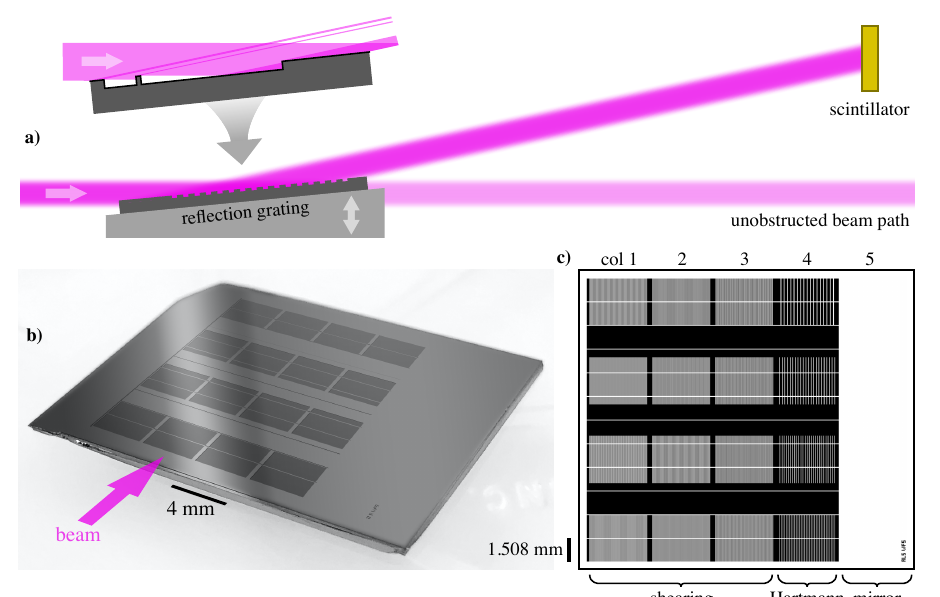
Figure 6. Illustration of the wavefront sensor grating array, its pattern, and use. ( a ) The narrow beam has a 2°, glancing angle of incidence and a longitudinal footprint longer than the array, so the four patterns in a column are illuminated at once. The inset grating cross-section detail shows how light reflects from the top surface, yet all other light is blocked by the thin walls and etched pattern features. At low angles, the detection-plane scintillator may be upright or inclined. The pattern ( c ) is etched into a silicon wafer chip ( b ), which is approximately 28mm wide. The pattern’s five columns contain 12 shearing gratings (Columns 1–3), four Hartmann grids (Column 4), and an open mirror region (column